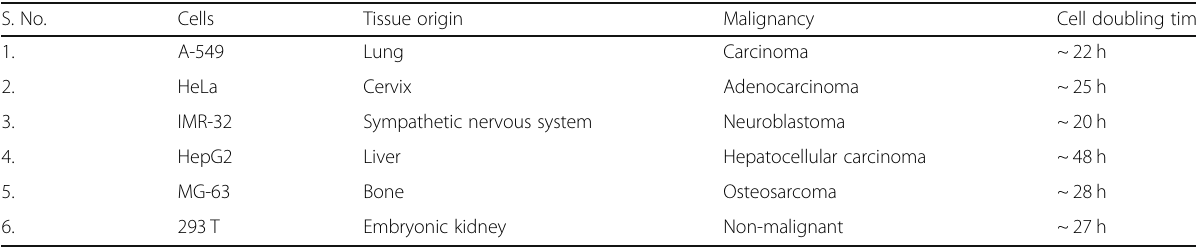
Table 2 Human cell lines utilized for the present study S.